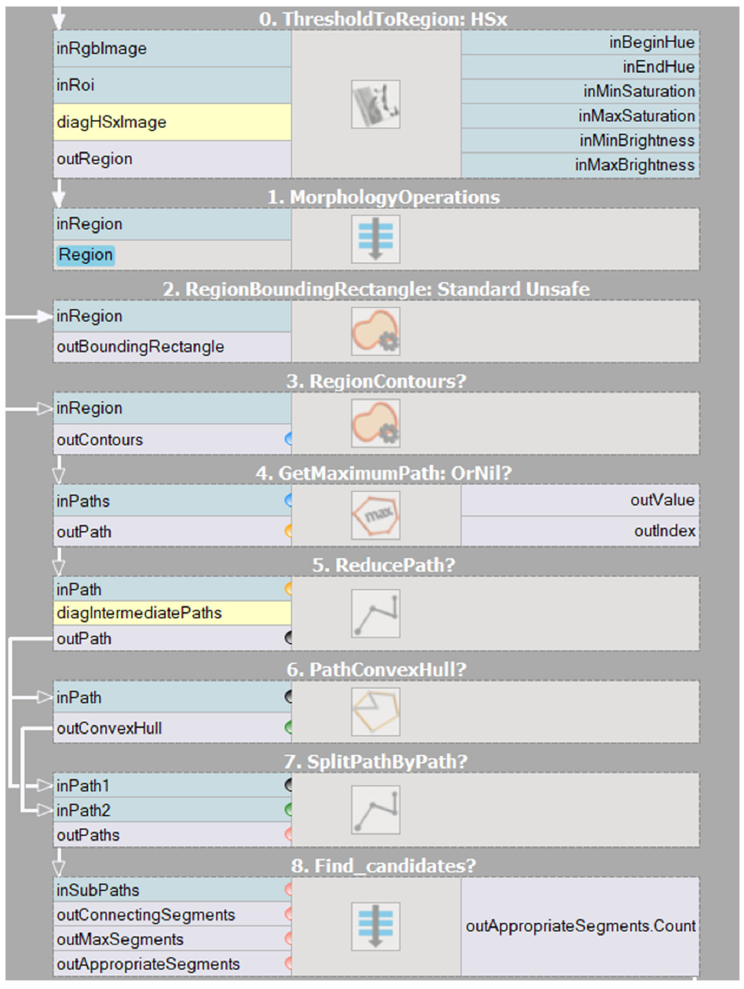
Figure 7. Developed hand gesture algorithm diagram in AVS